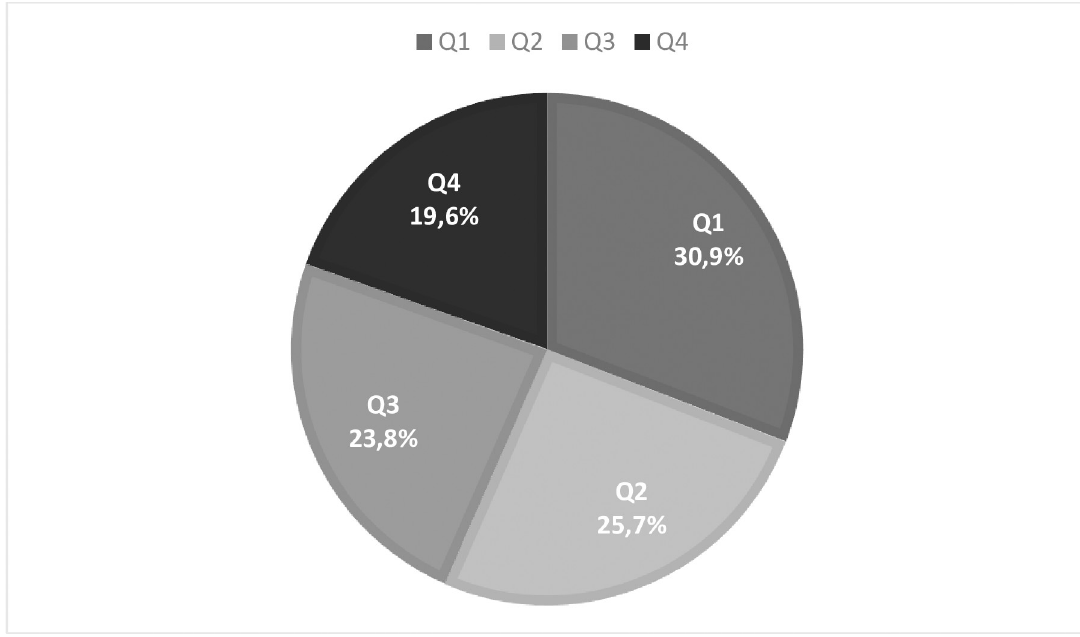
Fig 1. Distribution of players in all European championships by the quarter of birth.